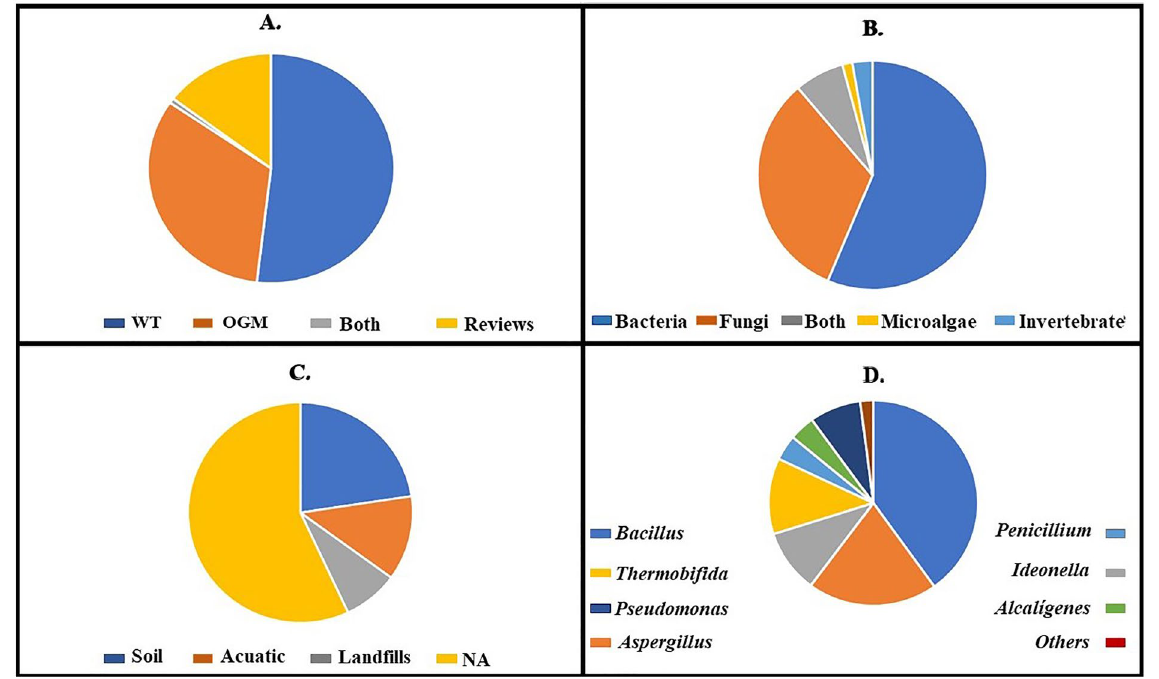
were isolated: soil (blue), water (orange), landfills (grey), and not specified in the publication (NA) (yellow). D Percentage of articles that used different genera of microorganisms in their research: Bacillus sp. (blue), Aspergillu s sp. (orange), Thermobifida sp. (yellow), Ideonella sp. (grey), Pseudomonas sp. (dark blue), Alcalígenes sp. (green), Penicillium sp. (light blue), and Others genera (red) such as: Spirulina sp., Streptococcus sp., Microsphaeropsis sp., Pleurotus sp., Mucor sp., Bipolaris sp., Fusarium sp., Clostridium sp., Hyphomonas sp., Alcanivorax sp., Halomonas sp., Rhizopus sp., Thioclava